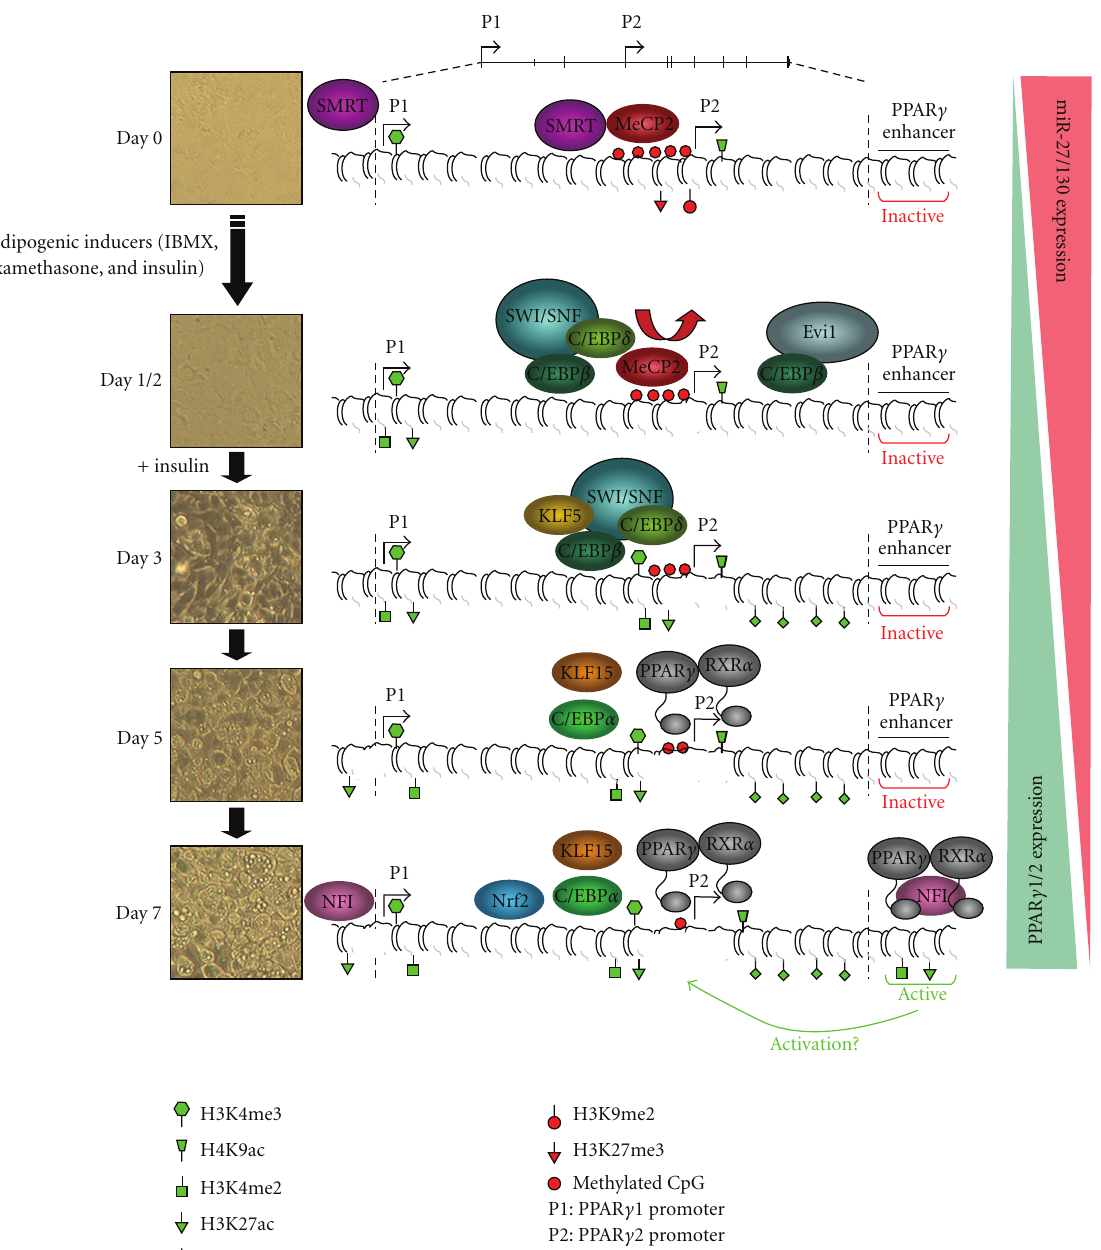
Figure 1: Chromatin-based regulation of PPAR γ expression in adipogenesis. Schematic describing epigenomic events as well as sequential transcription factor binding involved in the regulation of PPAR γ 1/2 expression during adipogenesis. Expression of miR-27/130 targeting PPAR γ is also